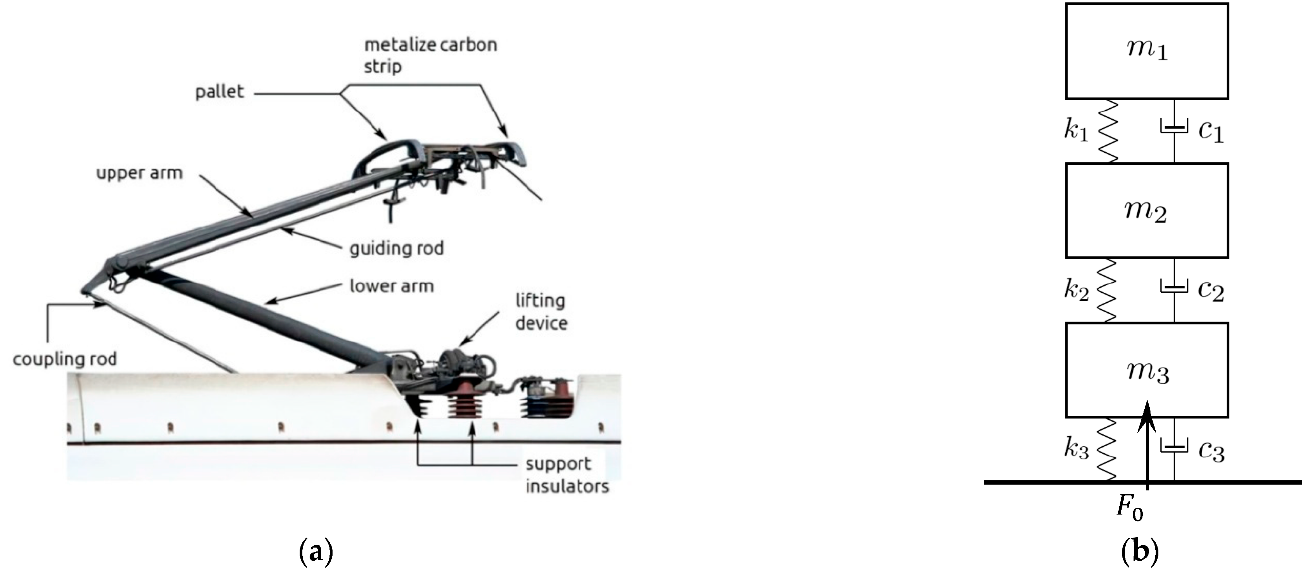
Figure 6. A lumped mass model of the pantograph. ( a ) Pantograph and its key components. ( b ) Equivalent lumped mass model. Table 2. Definition of parameters of the pantograph